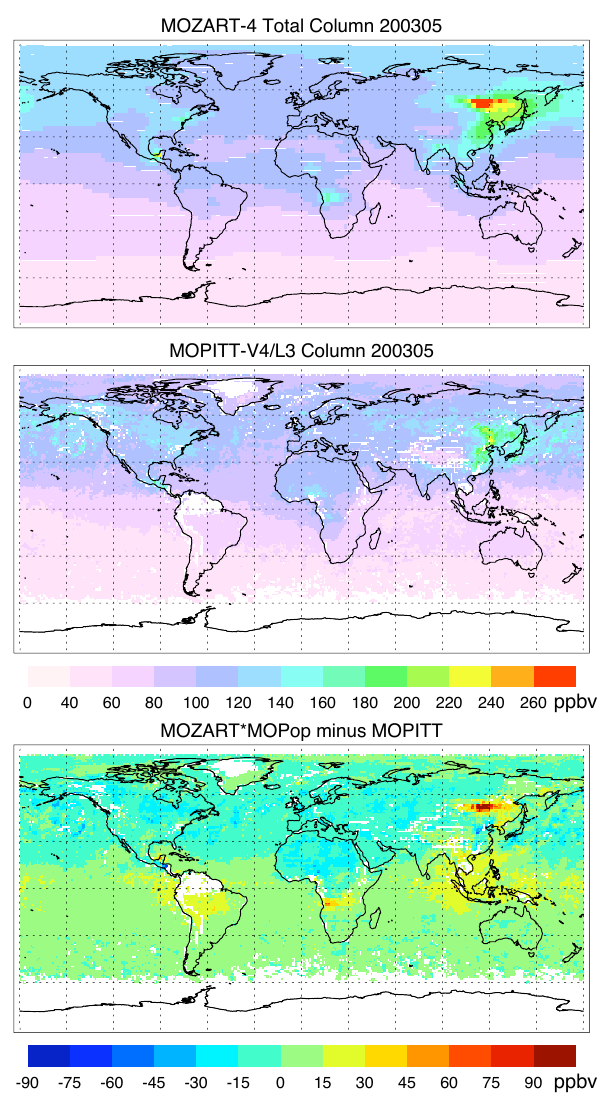
Fig. 6. Evaluation of MOZART-4 CO with MOPITT V4 CO total column densities; top: MOZART-4 CO total column average mix- ing ratio; middle: MOPITT CO total column retrieval as average mixing ratio; bottom: difference between MOZART-4 CO, trans- formed with the MOPITT operator (a priori and averaging kernels), and MOPITT CO, for May 2003.